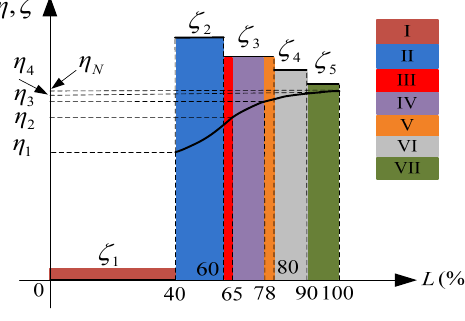
Figure 5. Optimization intervals division. Table 2. Operation intervals for CHP. Heat to power ratios: HTPR.